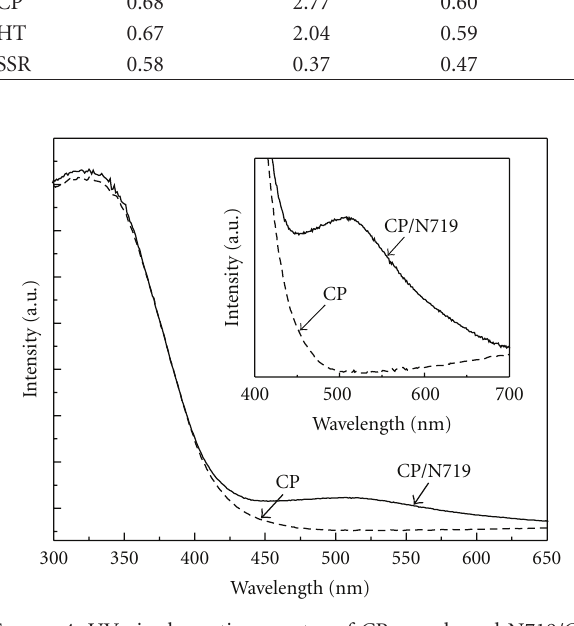
Table 1: The parameters of the BaSnO 3 electrode and PV performance of the DSSCs using di ff erent BaSnO 3 particles. Sample